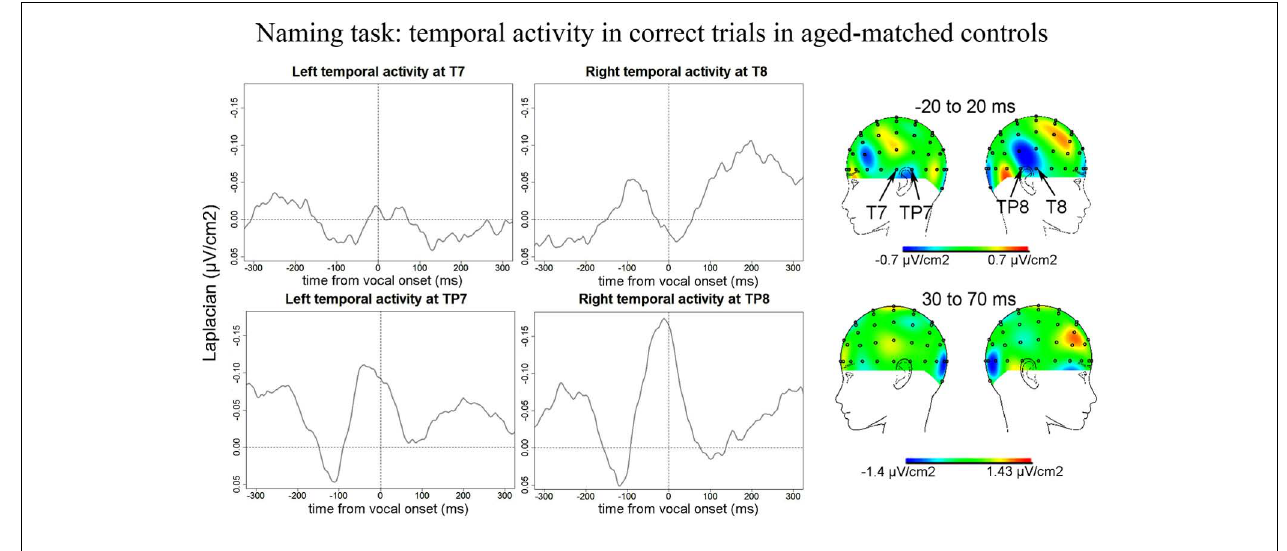
FIGURE 8 | EEG activity for control group after surface Laplacian transformation, recorded at left (T7,TP7) and right (T8,TP8) temporal electrodes for correct trials in the Naming task. Zero time represents vocal